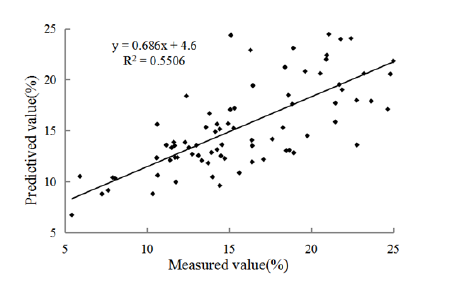
Figure 4. Estimated result of MLR